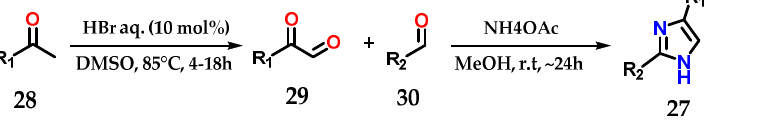
Figure 15. Disubstituted imidazoles 31 were obtained from the base-catalyzed condensation of am- idoximes 32 and methyl propiolate 33 . Amido-nitrile 34 cyclization mediated by functionalized boronic acids is also able to produce 2,4-disubstituted imidazoles 35 . It was possible to explore a considerable diver- sity of substituents, considering the reaction conditions reported below (Figure 16) [27]. Figure 16. Nickel-catalyzed cyclization of amido-nitriles 34 to obtain disubstituted imidazoles 35 . 2.3. Trisubstituted Derivatives On the other hand, 2,4,5-trisubstituted imidazoles 36 could be obtained by using 2,3- dioxo-3-substituted propanoates 37 as precursors after condensation using ammonium acetate and various aromatic aldehydes 38 in EtOH and AcOH as catalysts at room tem- perature (Figure 17) [28,29]. Figure 17. Obtaining 2,4,5-trisubstituted imidazoles 36 from 2,3-dioxo-3-substituted propanoates 37 . 2-Aryl-4,5-dicarbonitrile imidazole derivatives 39 could be obtained from the cou- pling of substituted aromatic aldehydes 40 and 2,3-diaminomaleonitriles 41 in the pres- ence of a mixture of cerium (IV) ammonium nitrate/nitric acid (CAN: NA|0.05: 0.4 eq.) at 120 °C for less than 1 h without using solvents (Figure 18) [30].